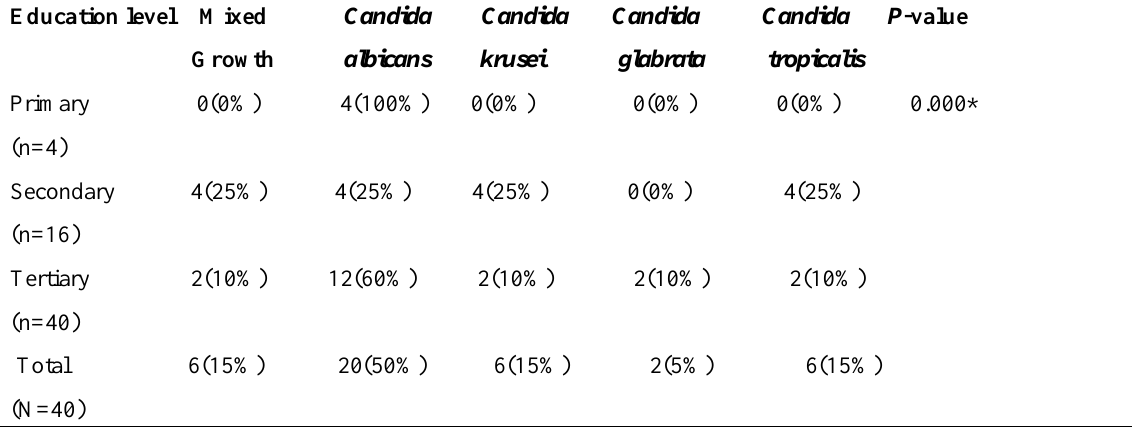
Table 8. Candida isolates based on the level of education of the participants.